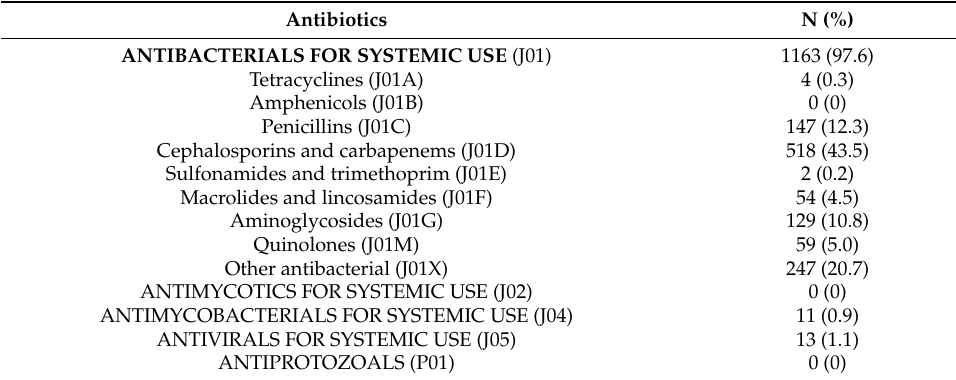
Table 2. Prevalence of the main antimicrobial